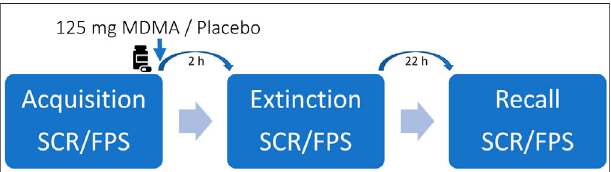
FIGURE 1 | Schematic study day. Participants underwent every two sessions with either 125-mg 3,4-methylenedioxymethamphetamine (MDMA) or placebo. The order was randomized but balanced. The washout period between the study days was at least 30days. Autonomic and subjective effects were assessed throughout the study day. Blood samples for MDMA and oxytocin blood plasma concentrations were collected before and periodically up to 24 h after drug